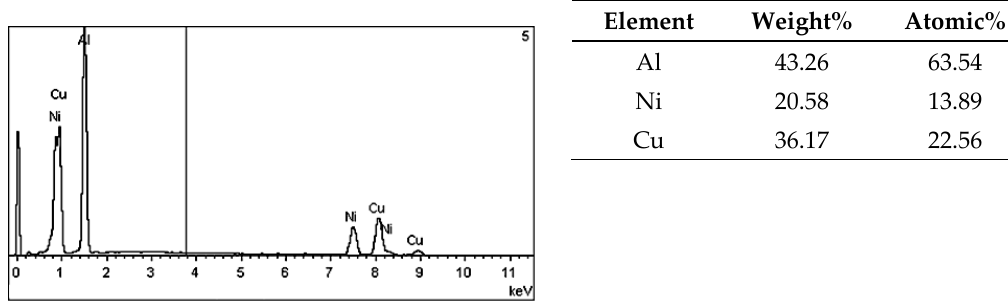
Figure 9. EDS diagram and chemical composition at point no. 4 of Figure 5.